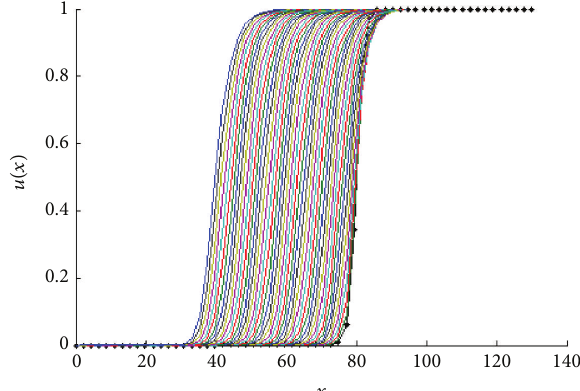
Figure 15: Front traveling waves solutions of (39) for ℎ 󸀠 (𝑢) = 𝛼+𝛾𝑢 at equal time intervals 𝑡 = 1, 2, 3, .. . with 𝑔(𝑢) = 𝑢(1−𝑢) and 𝐷(𝑢) = 𝑢(1.0 + 𝛽𝑢) for 𝛽 = 𝑘 = 1 .